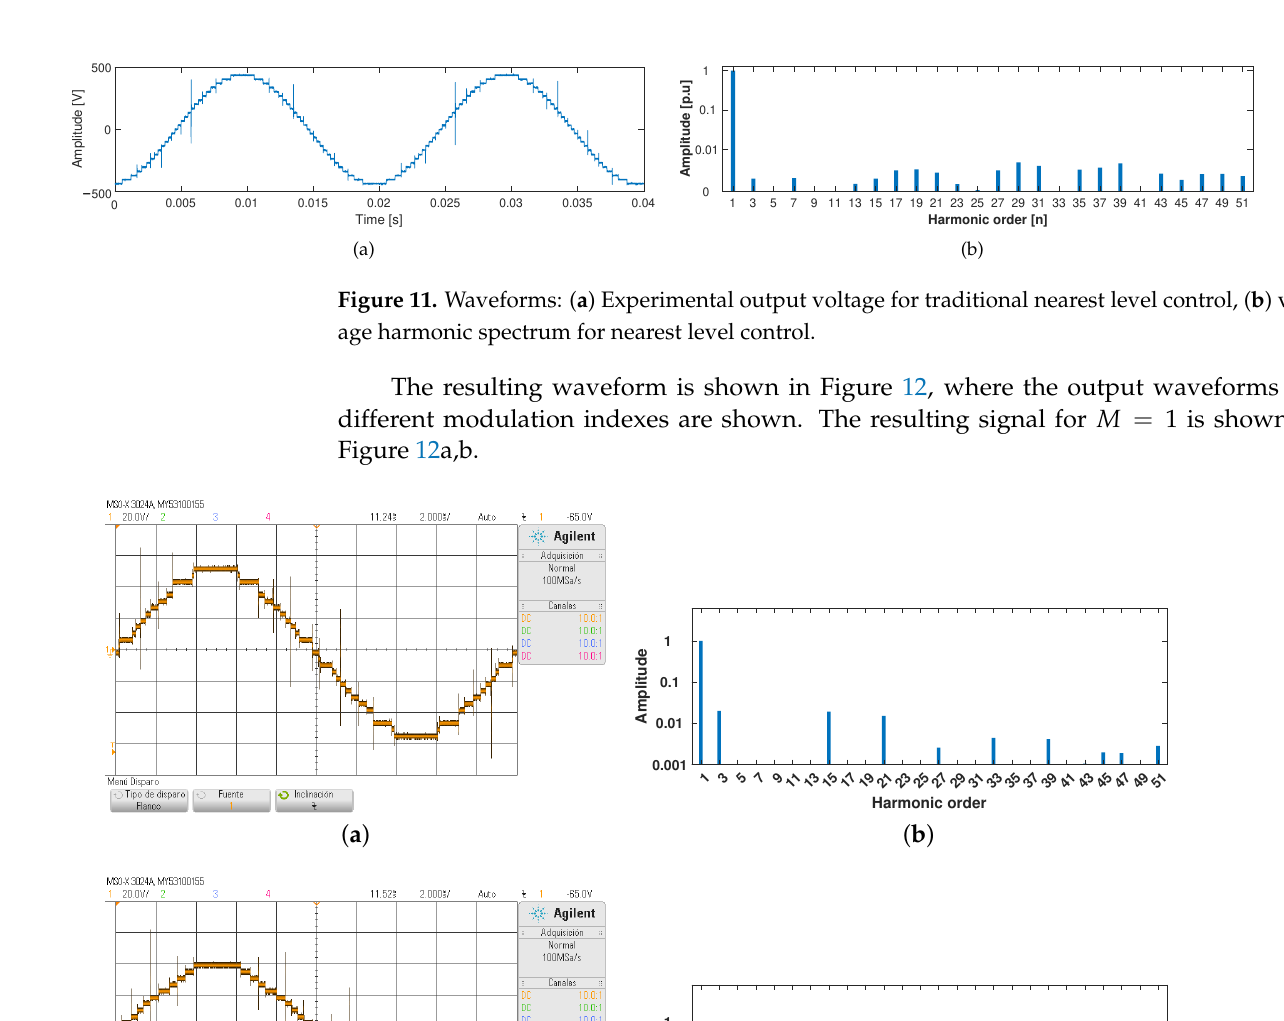
Table 4: THD for different Modulation Indexes